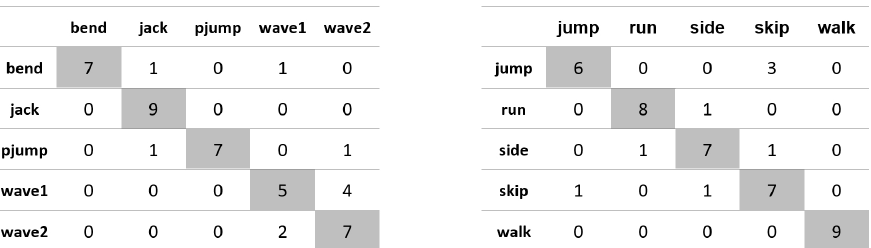
Figure A18. Confusion matrices for the experiment using the ‘lower-occlusion’ database, MBR perimeter and C1 correlation.